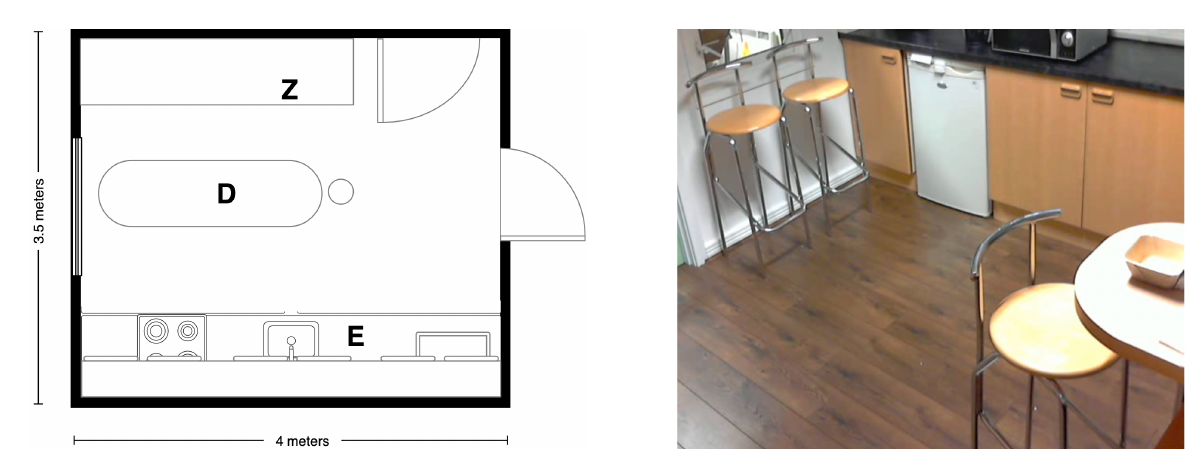
Figure 4. Sketch and photograph of the kitchen. The photograph was taken from position Z.